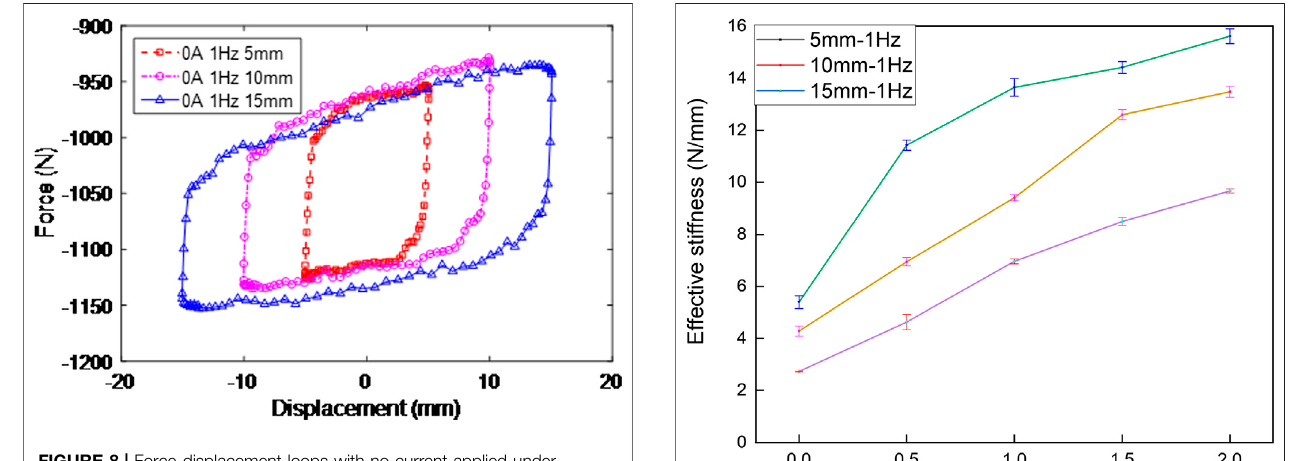
FIGURE 8 | Force-displacement loops with no current applied under different excitation amplitudes.